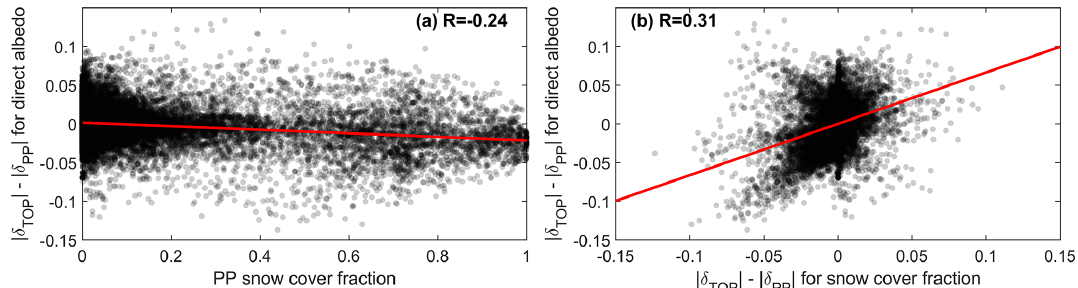
Figure 11. Relationship between the differences in bias for TOP and PP ( | δ TOP | – | δ PP | ) with respect to MODIS data for direct albedo and PP simulated snow cover fraction (a) or the differences in bias for TOP and PP ( | δ TOP | – | δ PP | ) for snow cover fraction (b) in winter. The red line is the regression line, and R is the correlation